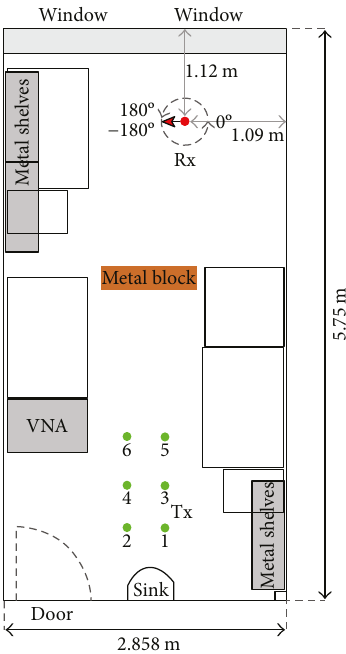
Figure 5: Small o ffi ce